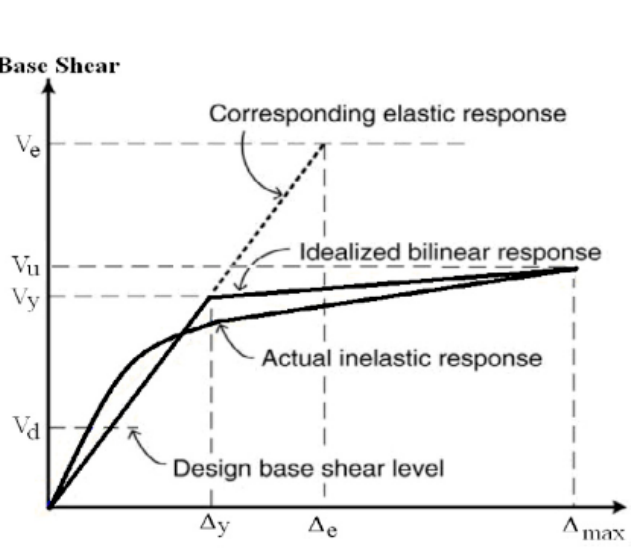
Figure 23. Load vs. displacement bilinear graph [27].